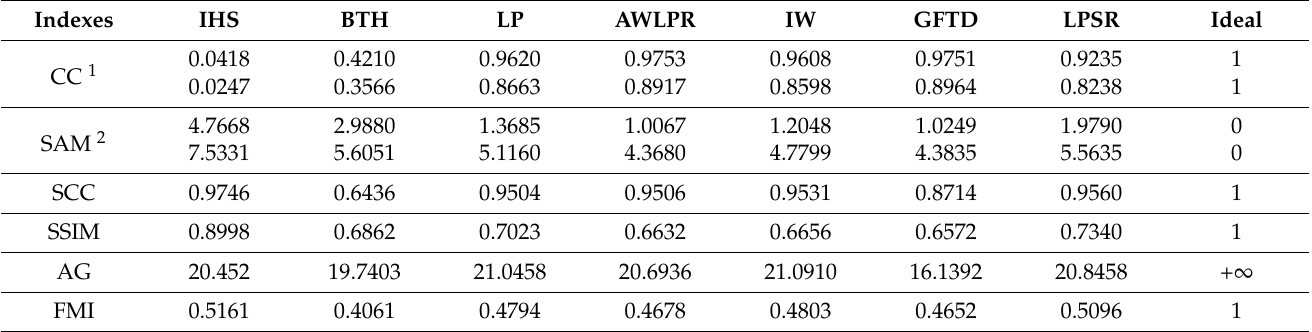
Table 1. Quantitative evaluation results of different fusion methods in area